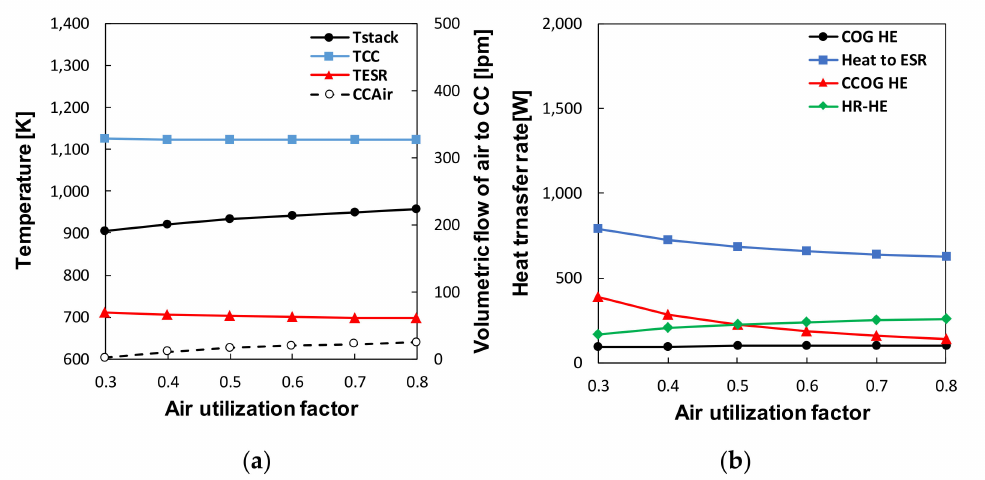
Figure 4. The effect of air utilization factor on the reference system; ( a ) temperature of each com- ponent, ( b ) heat transfer rate at each heat exchanger (COG HE: steam generator, CCOG HE: air pre-heater, HR HE: heat recovery heat